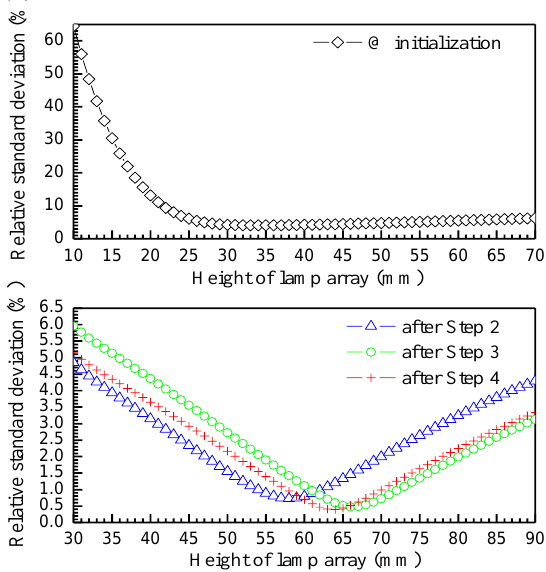
Figure 3. The relative standard deviation vs. the height of lamp array. The upper frame: RSD vs. the height of lamp array at the initialization condition; the lower frame: RSD vs. the height of lamp array after Step 2, 3 and 4, respectively.